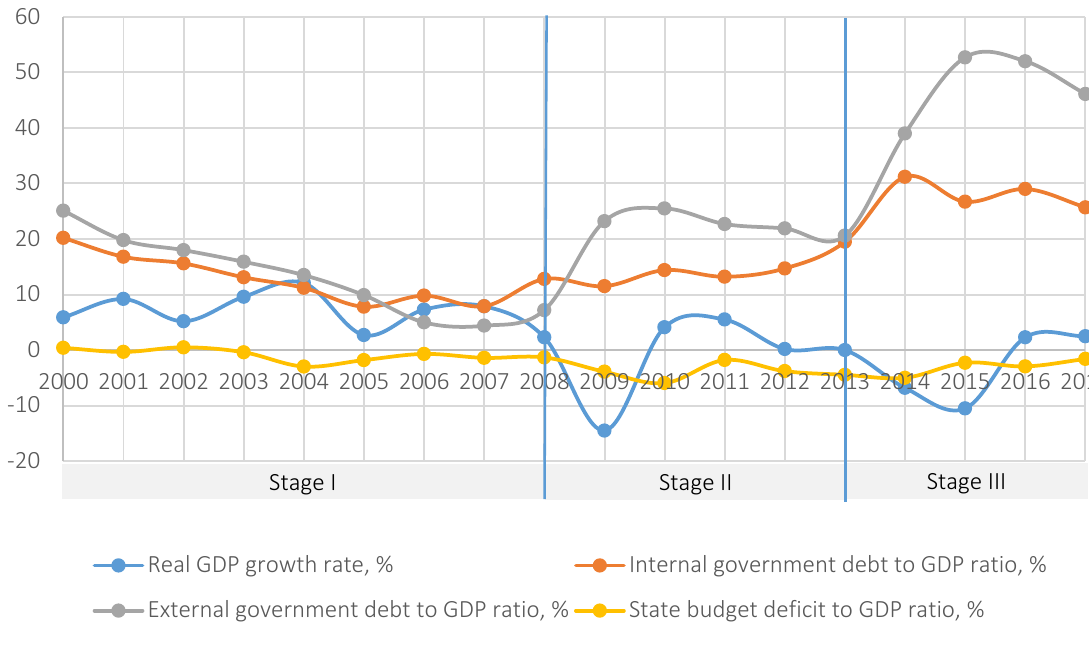
Figure 2. Graphic presentation of real GDP growth rate and the